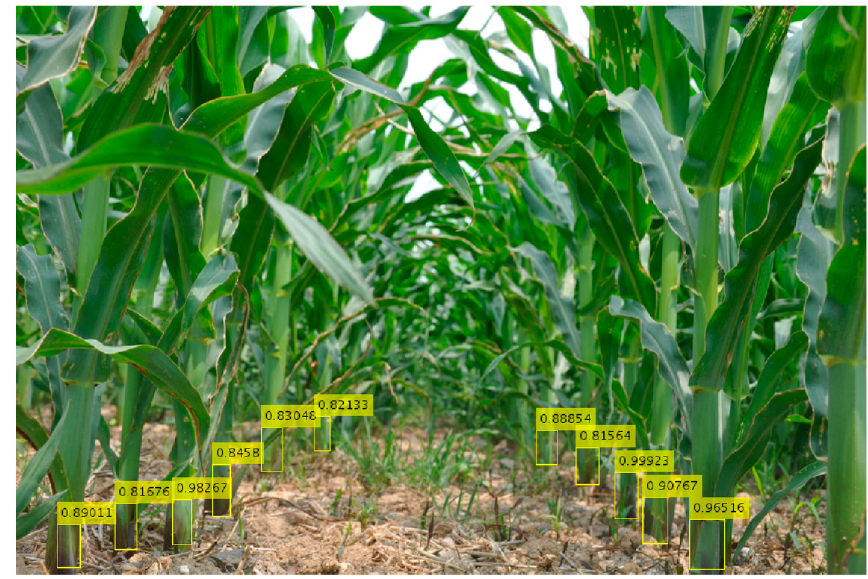
Figure 6. Detection of rhizomes between rows of maize.